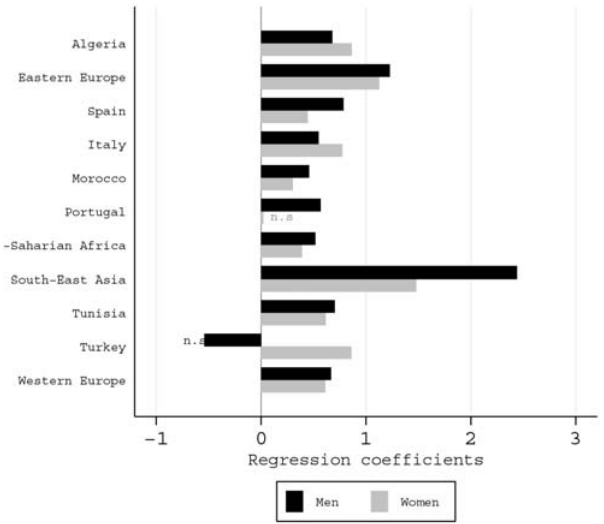
Figure 3: Second generation coeffecients for each country (interaction